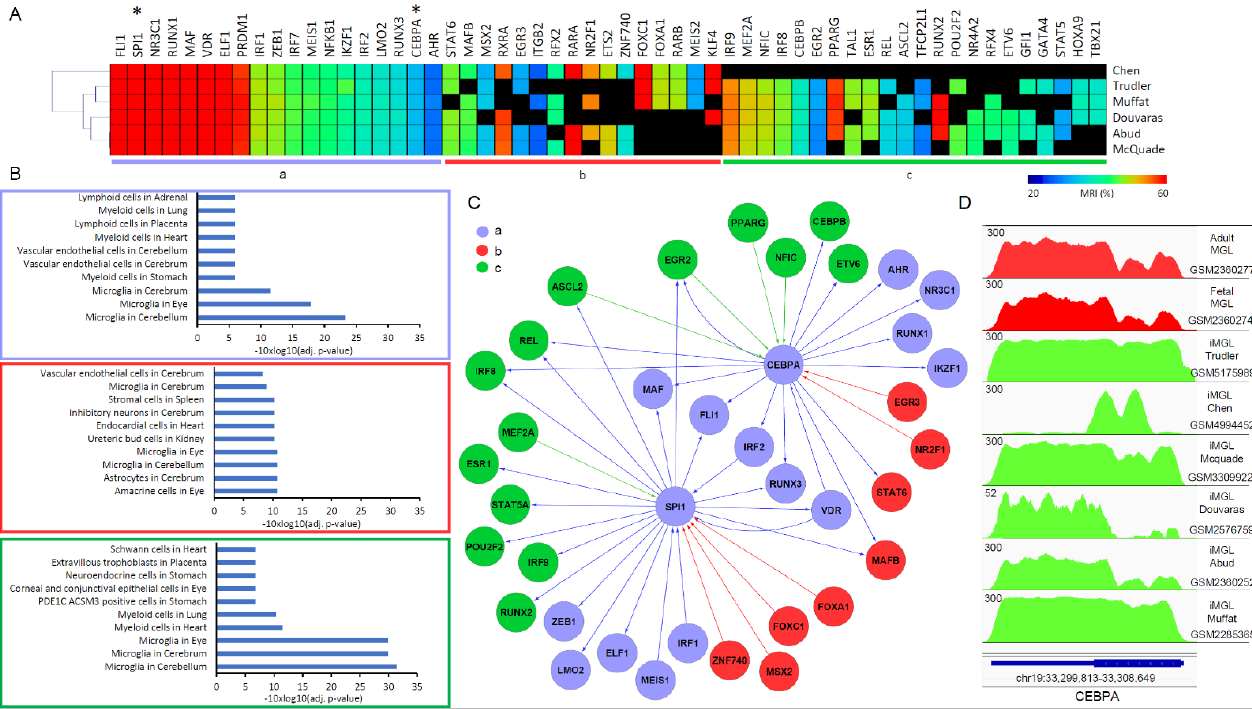
Figure 4. In silico prediction of a consensus master transcription regulatory circuitry driving microglia differentiation. ( A ) Master transcription factors predicted from the reconstruction of gene regulatory networks (GRN) and conserved in at least three over six of the studied protocols. Heatmap corresponds to their master regulatory index (MRI), which corresponds to the fraction of downstream target players (direct or indirect) that can be controlled by the TF within the reconstructed GRN (in percent). Transcription factors were organized into three groups: (a) those that were retrieved in the datasets issued from all protocols; (b) those retrieved from datasets generated by Chen et al. and at least two other protocols; and (c) those retrieved from at least three protocols except Chen’s protocol. The transcription factors SPI1 and CEBPA, which were over-expressed in the protocol described by Chen et al., are part of group (a), as highlighted by the “*”. ( B ) Cell ontology analysis was performed for each of the TF groups described in ( A ). ( C ) SPI/CEBPA co-regulatory network displaying their first TF neighbors within the master players listed in ( A ). The color-code associated with each node corresponds to the groups described in ( A ). Similarly, edges are colored in agreement with the color of the source node. ( D ) RNA-sequencing read count enrichment at the CEBPA locus for iMGL datasets issued from the different protocols (green) as well as the fetal and adult control samples (red). Notice the shorten read count enrichment pattern observed for the sample associated with the protocol described by Chen et al. relative to all other datasets. Enrichment read count levels were set to 300 for their enhanced comparability.